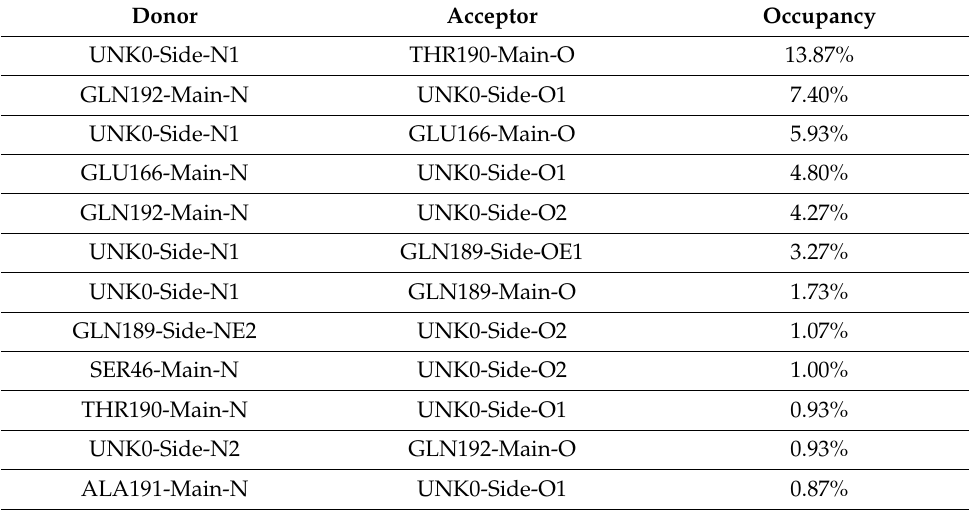
Table 6. H-bond occupancy of caprolactin A-M pro complex.